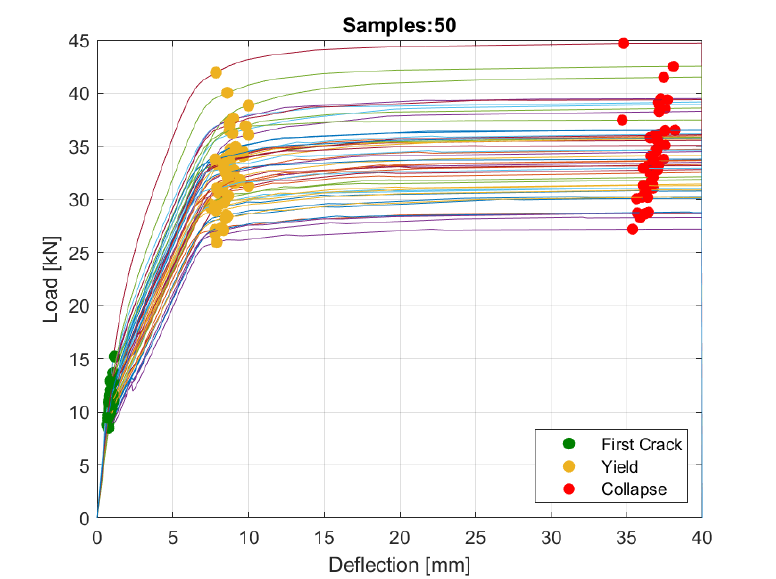
Figure 12. Load–deflection relations for 50 realizations of the proposed probabilistic numerical model obtained using MC sampling.